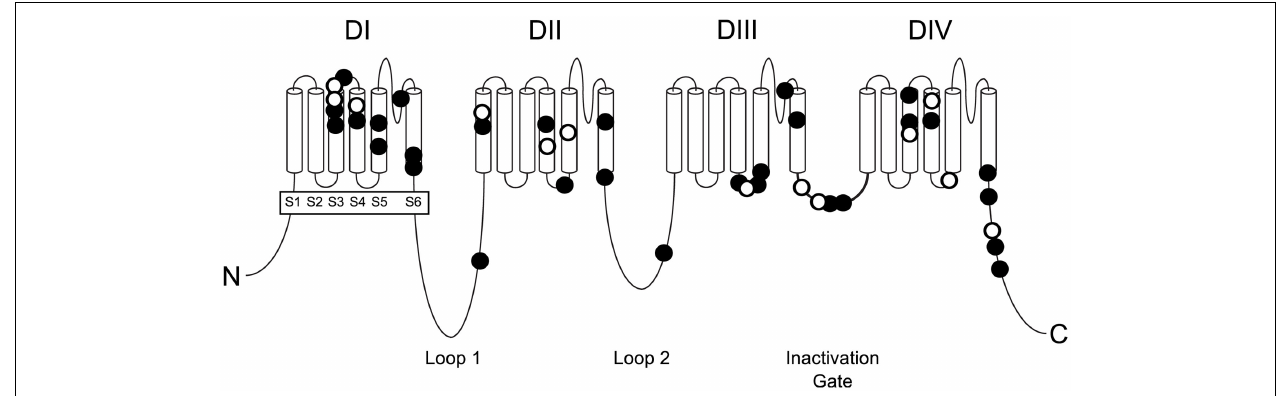
well-conserved than the transmembrane and linker domains. Loop 3 functions as the inactivation gate and is very highly conserved. Closed symbols, EIEE13 mutations in a single patient; open symbols, recurrent mutations.